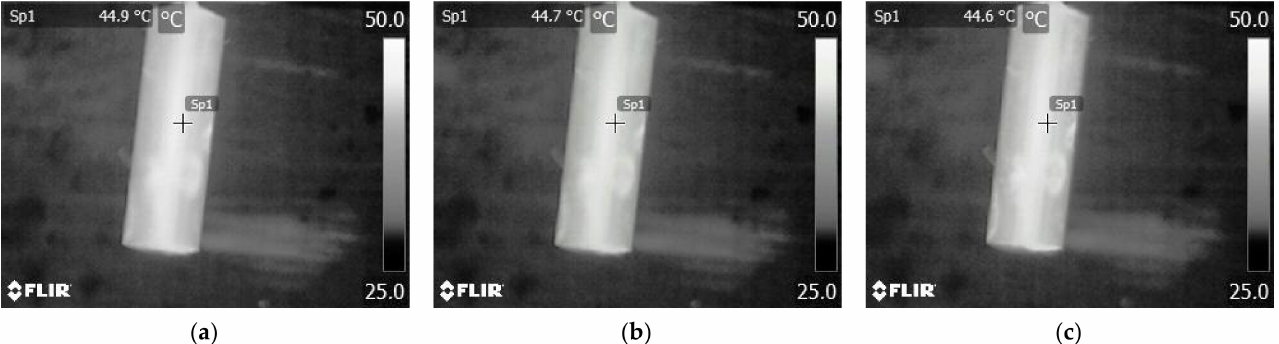
Figure 1. Thermograms presenting the Pt 1000 temperature sensor in a cylindrical case with a diameter of 3 mm. The thermograms are taken with the following distances between the lens and the object under observation: ( a ) 33 mm—distance between the additional thermographic camera lens and the observed object, as proposed by manufacturer. Temperature measured in Sp1 = 49.6 ◦ C; ( b ) 33.1 mm. Temperature measured in Sp1 = 49.5 ◦ C; ( c ) 34 mm—maximum allowable value of the distance between lens and object, which allows obtaining a sharp thermogram (by manufacturer). Temperature measured in Sp1 = 49.3 ◦